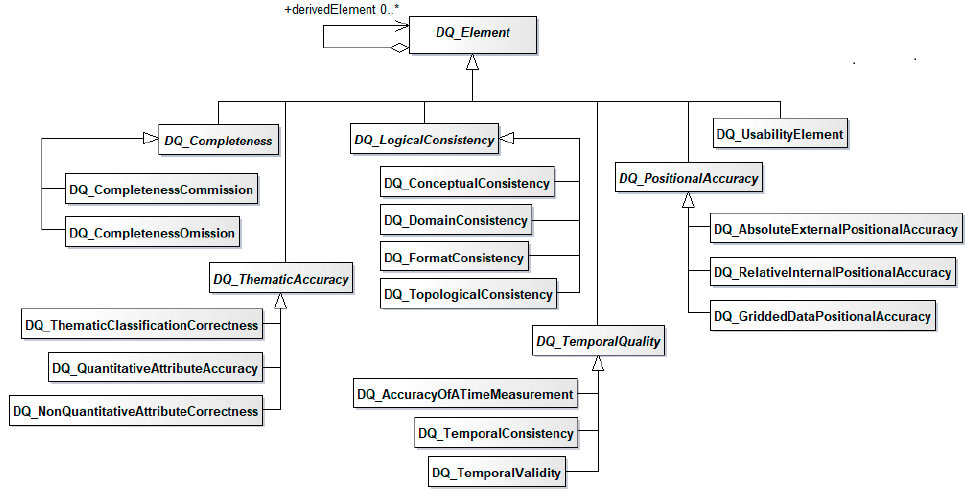
Figure 6. ISO 19157 quantitative data quality elements.